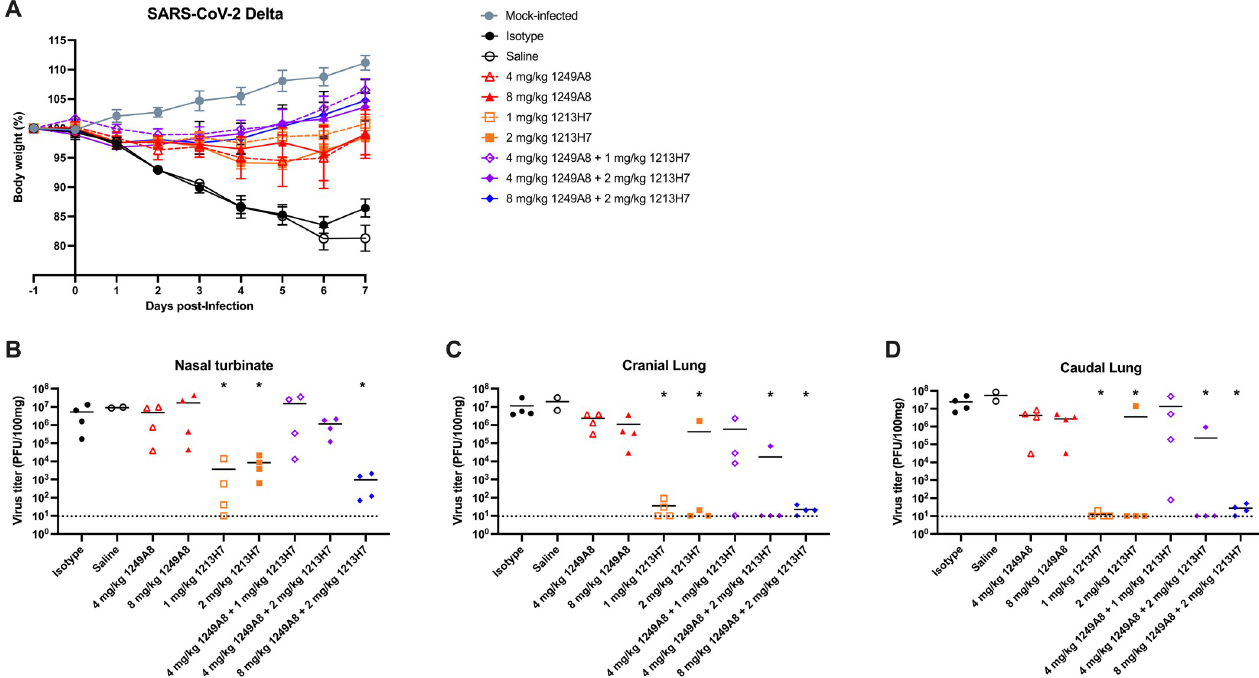
Fig 6. Therapeutic activity of intranasal 1249A8 and 1213H7 in hamsters infected with SARS-CoV-2 Delta. Golden Syrian hamsters were infected i.n. with 10 4 CCID 50 SARS-CoV-2 Delta and 12 h p.i. treated i.n. with a single dose of indicated mAb(s). n = 4–8 per group. ( A ) Body weight was measured daily. Mean ± SEM indicated. Nasal turbinate ( B ), cranial lung ( C ), and caudal lung ( D ) viral titers were measured at 3 d p.i. by plaque assay. Each symbol represents an individual animal. Dotted line indicates limit of detection, titers below limit of detection are presented at limit of detection. � indicates p < 0.05 compared to isotype control group as determined by one-way ANOVA.